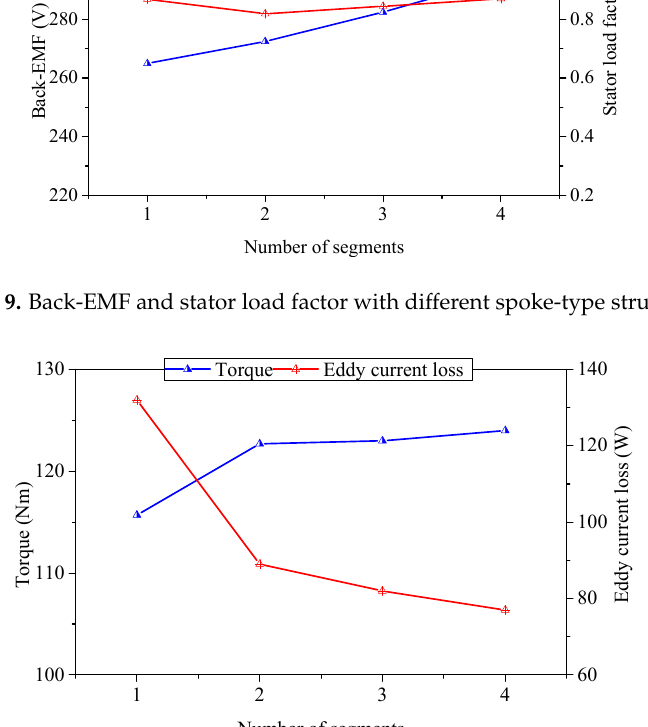
Figure 10. Torque and eddy current loss with different spoke-type structures.